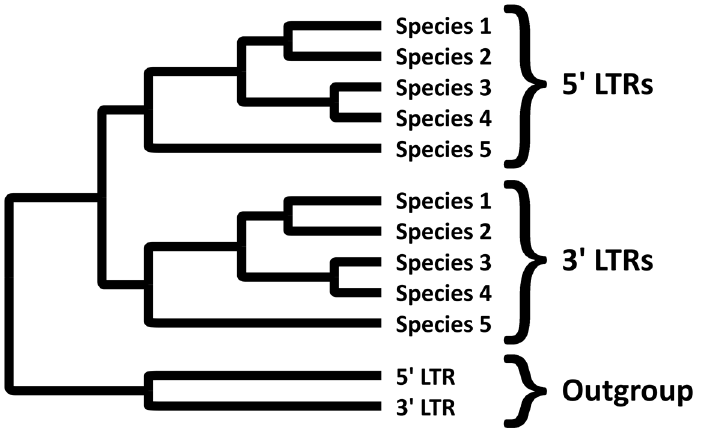
Figure 2. An ideal phylogenetic tree of LTRs of an orthologous ERV in five species. When the ERV integrates in the common ancestor, the 5 ′ and 3 ′ LTRs are identical. They then drift apart as they incur mutations. The two LTRs each keep an independent record of subsequent speciation events.